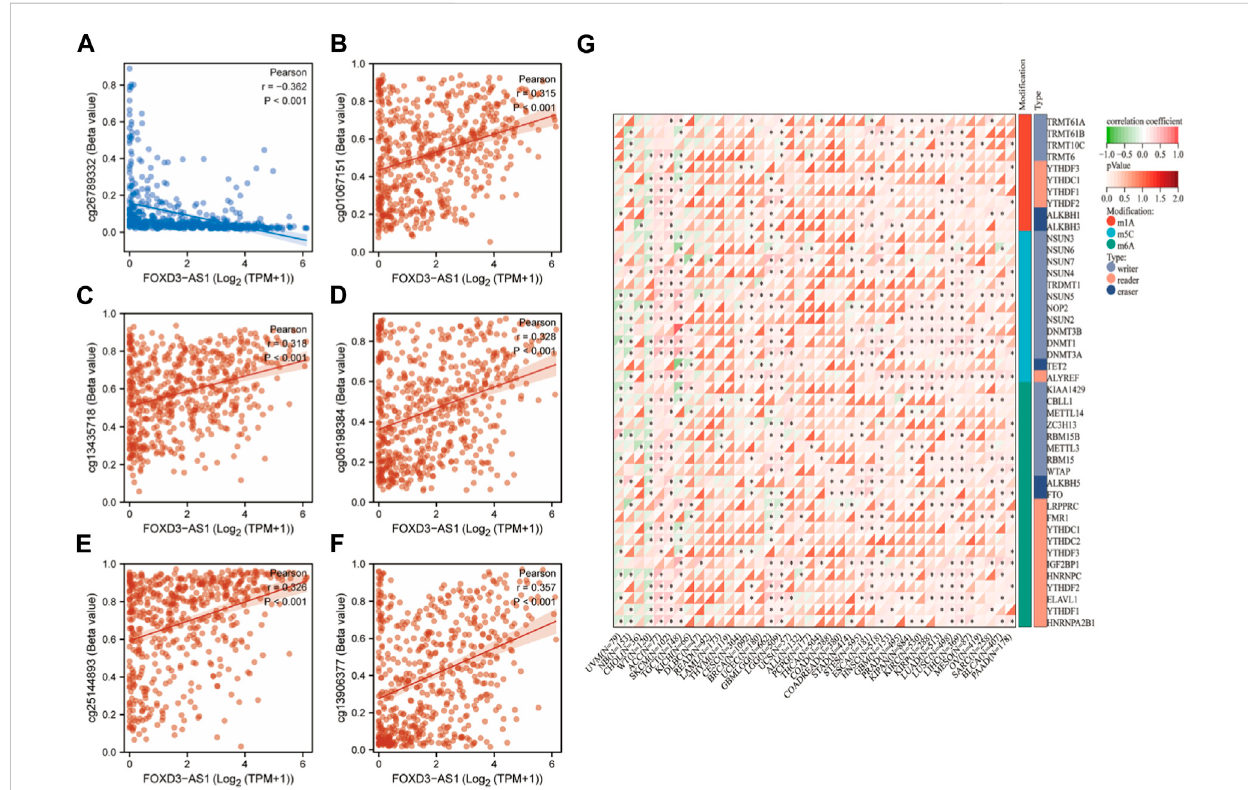
FIGURE 3 RNAmodi fi cationcorrelationanalysisofFOXD3-AS1. (A – F) FOXD3-AS1inTCGA-GBMLGGispositivelycorrelatedwithcg26789332(r= − 0.362, p < 0.001), cg01067151 (r = 0.315, p < 0.001), cg13435718 (r = 0.318, p < 0.001), cg06198384 (r = 0.328, p < 0.001), cg25144893 (r = 0.326, p < 0.001) and cg13906377 (r = 0.357, p < 0.001) respectively; (G) Scatter diagram of FOXD3-AS1 ’ s correlation with RNA modi fi cation related genes (m1A, m5C, m6A) in pan